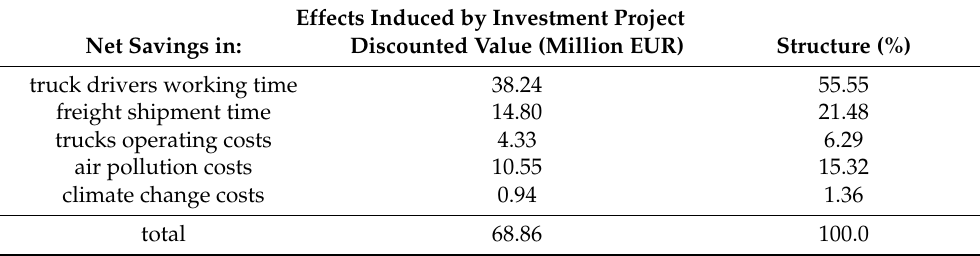
Table 4. Total and discounted sustainable monetized effects induced by the investment in 2024–2043.